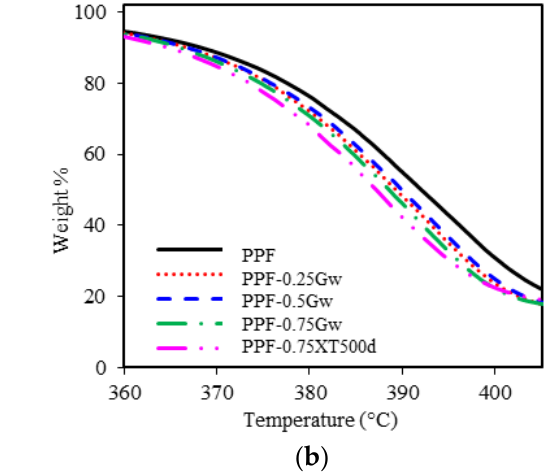
( b ) Figure 8. ( a ) Thermogravimetric curves of PHF samples; ( b ) zoomed region. Temperature and frequency dependent mechanical relaxation data for amorphous PPF and semicrystalline PHF were recorded via storage modulus (E′) and tan δ, which is the ratio of the loss modulus to storage modulus. Such data can provide indications about the mechanical reinforcement, which is correlated to a good interface interaction filler/ma- trix due to the presence of van der Waals forces or π–π interactions [50]. In Figures 9 and 10 the changes of E’ and tan δ as function of temperature for all the investigated samples are plotted. Concerning the PPF samples, E′ values of graphenic composites decrease re- spect to the homopolymer (Figure 9a,b). This indicates that no mechanical reinforcement of the matrix has been induced by graphene, probably because of the presence of surfac- tant. In fact, only PPF-0.75XT500d presents, from low temperature up to room tempera- ture, a moderate enhancement in storage modulus E’, quantifiable as 6–12%. The larger storage modulus for such composite indicates a slight mechanical reinforcement of the matrix due to a better interfacial interaction filler/polymer, possibly ascribable to the ab- sence of surfactant or to the chemical environment, which could help in preventing the restacking of the sheets, being PD a co-monomer during PPF polycondensation. Similarly, a slight reinforcing effect of graphene in E’ was reported with PMMA [51]. The authors reported also an increase in tan δ peak due to a restricted mobility of the PMMA chains through strong chemical interactions between the polar groups of the pol- ymer and the remaining oxygen functionality of the graphene [51]. Akhina et al. obtained an increase in storage modulus below the glass transition temperature and a slight shift